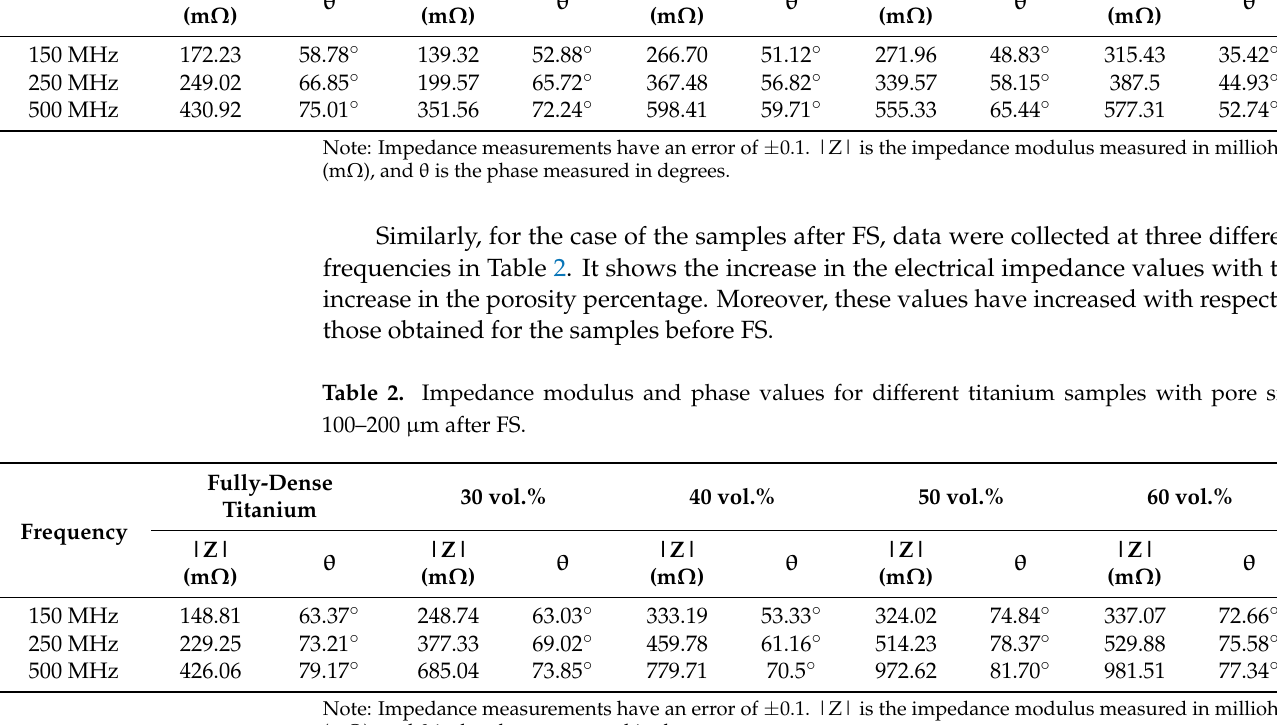
Table 1. Impedance modulus and phase values for different titanium samples with pore size 100-200 µm before FS.